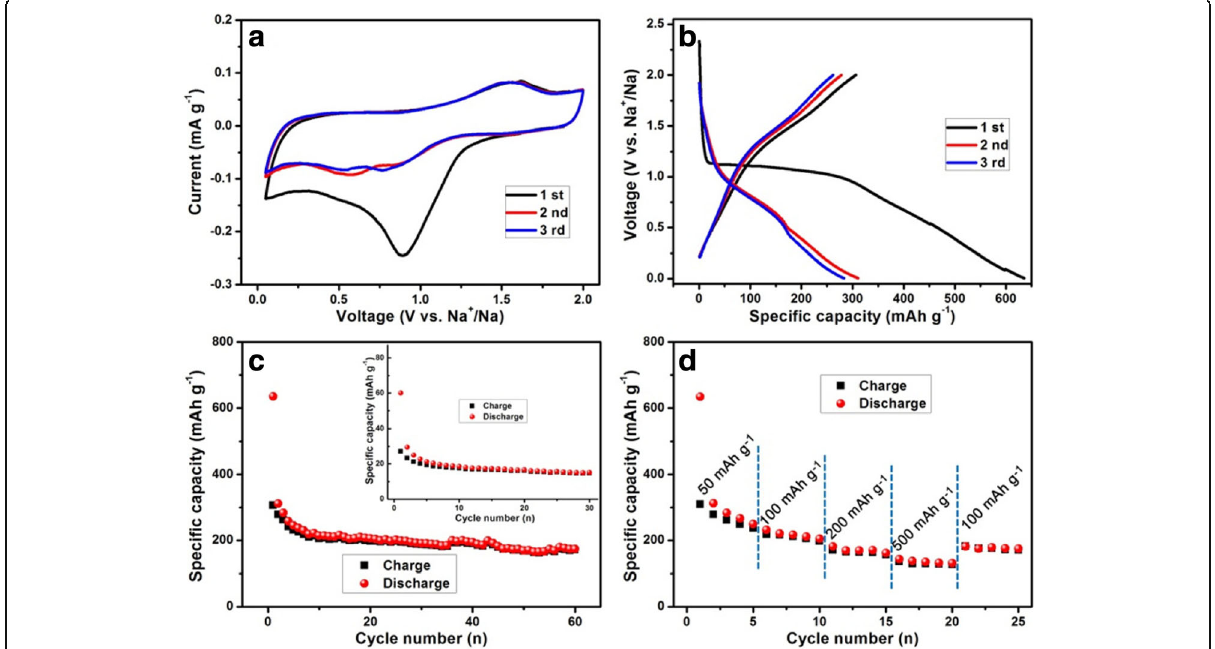
Fig. 3 a The initial three CV curves of CGO nanowires at a scanning rate of 0.2 mV s − 1 . b The initial three charge/discharge curves and c cycling performance of the CGO nanowires at a current density of 50 mA g − 1 . Inset in c is the cycling performance of the elemental Ge at a current